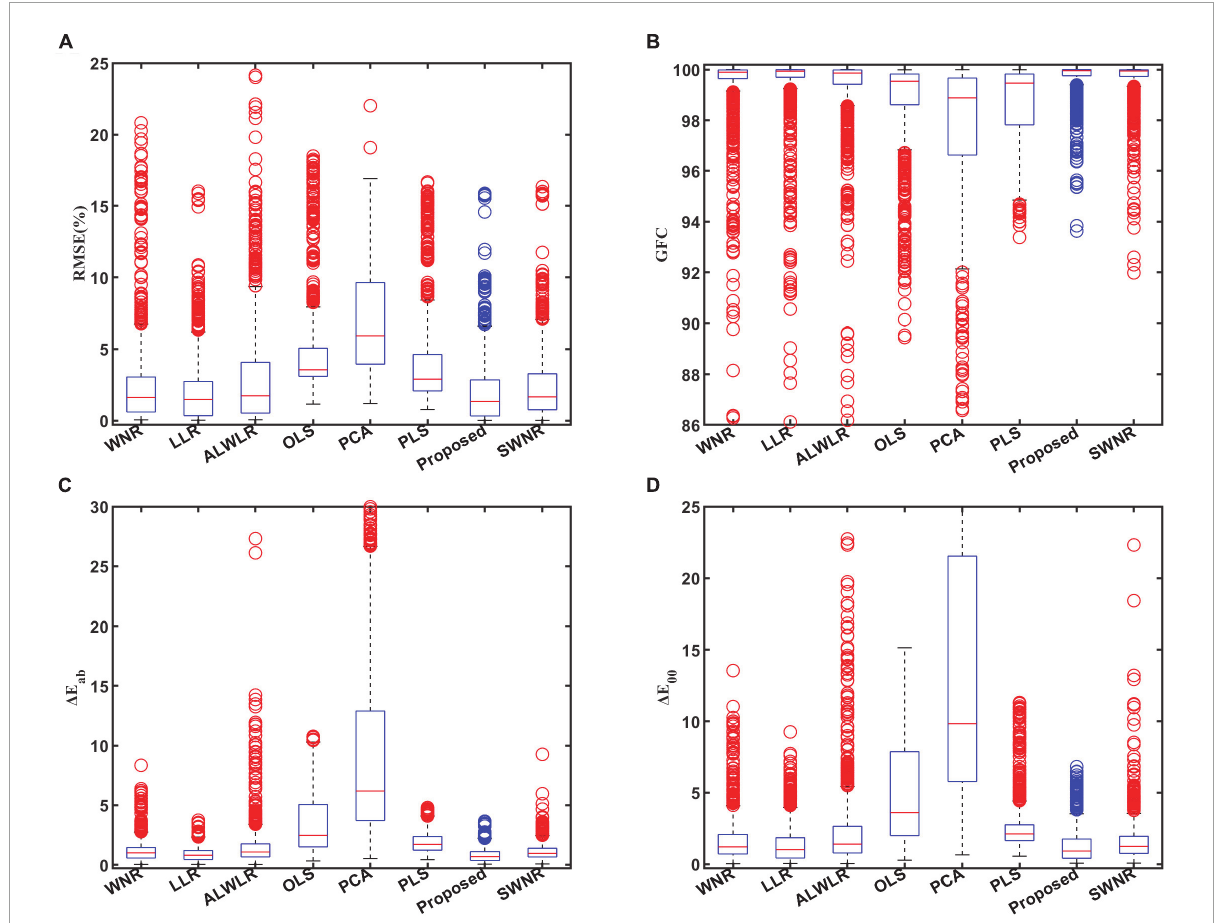
FIGURE6 Boxplots of estimation errors for the comparison of eight methods: (A) RMSE, (B) GFC, (C) (cid:49) E ∗ ab , and (D) (cid:49) E 00 .